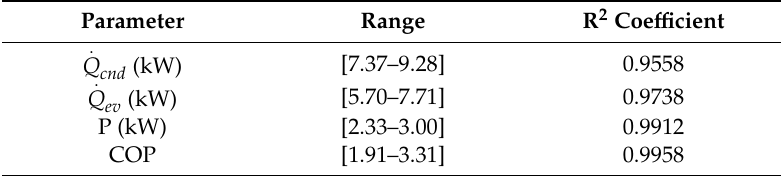
Figure 3. Vapor compression systems (VCS) model structure. Table 2. Adjusted R 2 coe ffi cients for the Vapor compression systems (VCS) regression